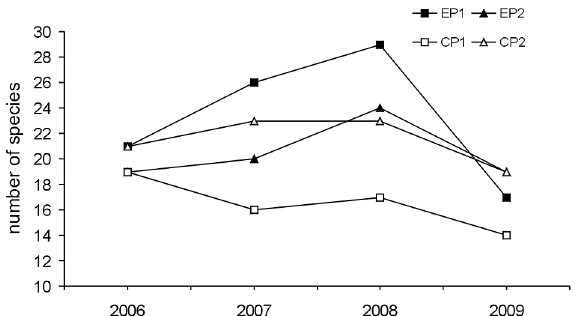
Fig. 5. Changes of floristic richness of sedge dominated patches caused by yearly mowing in different parts of the Chwiszczej river valley. EP1/CP1 – experimental/control plots in marginal zone, EP2/CP2 – experimental/control plots in riverbed-adjacent